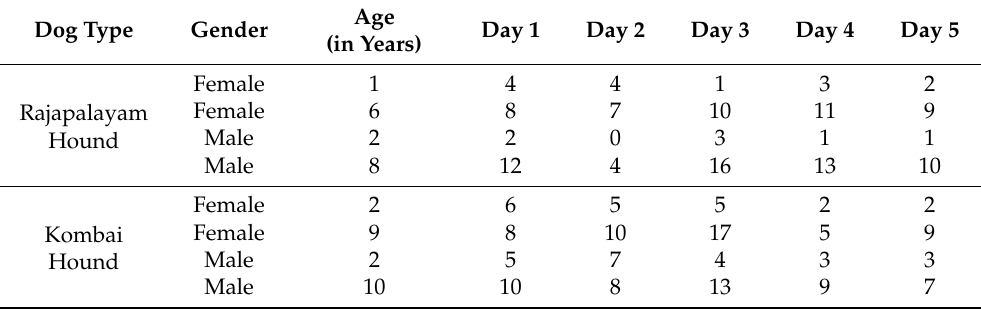
Table A3. Dog Sounds Recorded While Playing with a Ball.